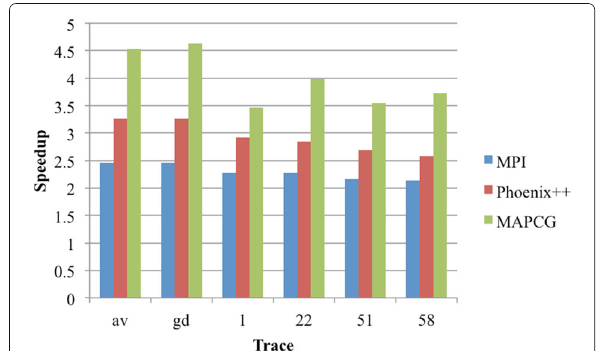
Fig. 4 Speedup over the serial implementation